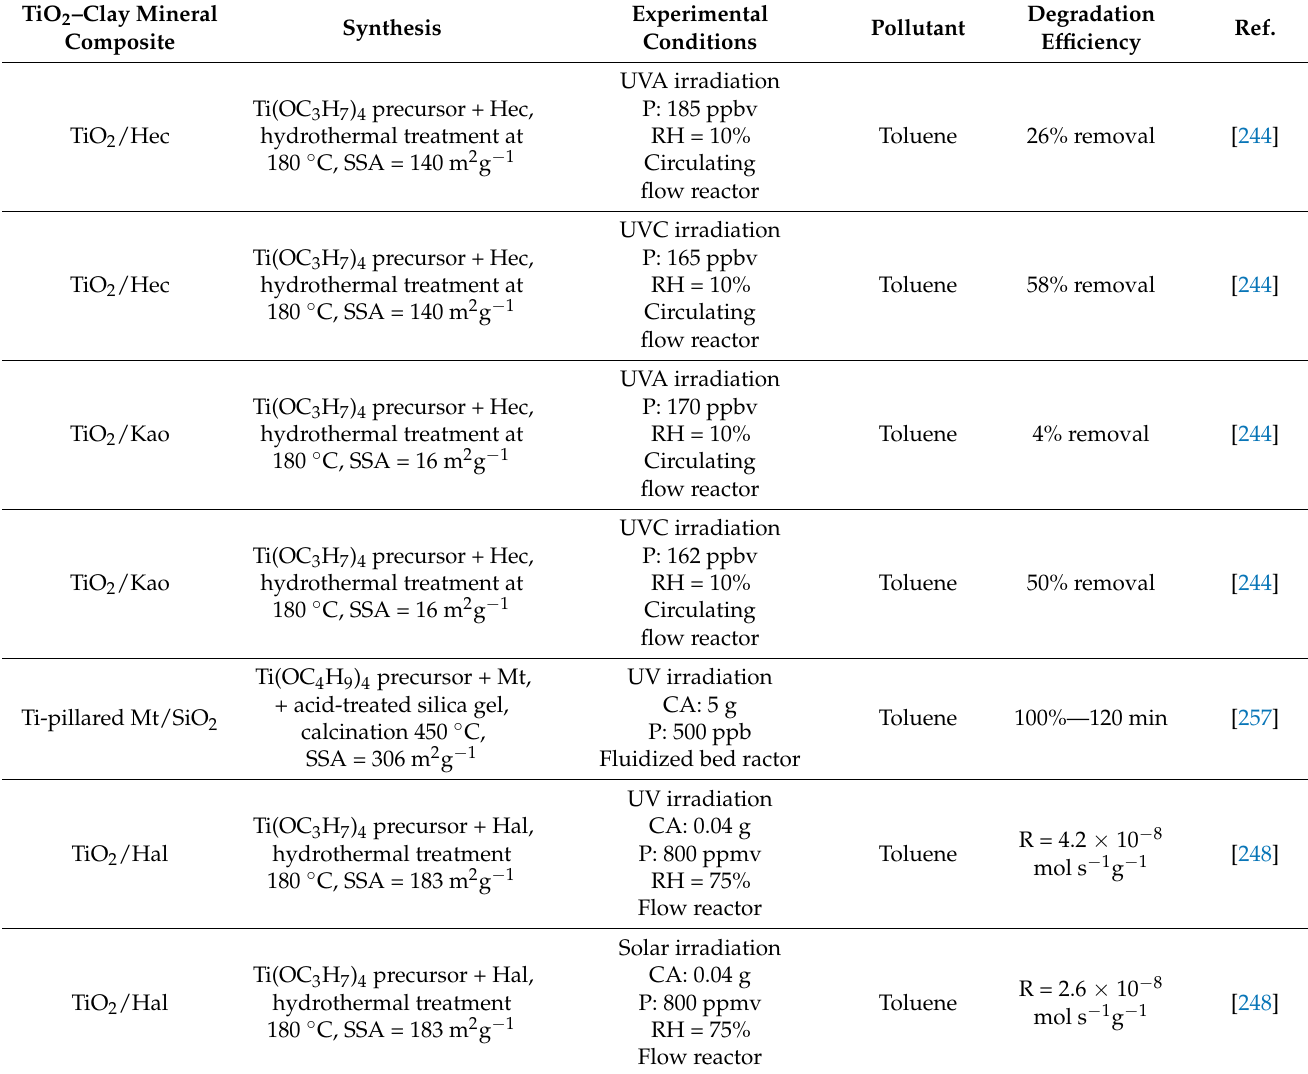
Table 8. Main synthesis and photocatalysis data for selected examples of TiO 2 composites with clay minerals used for the degradation of gasous pollutants in air (Hal—halloysite, Hec—hectorite, Kao—kaolinite, Lap—Laponite, Mt— montmorillonite, Pal—palygorskite, Sep—sepiolite,CTA—cetyltrimethylammonium cation, P—pollutant, CA—catalyst amount, R—reaction